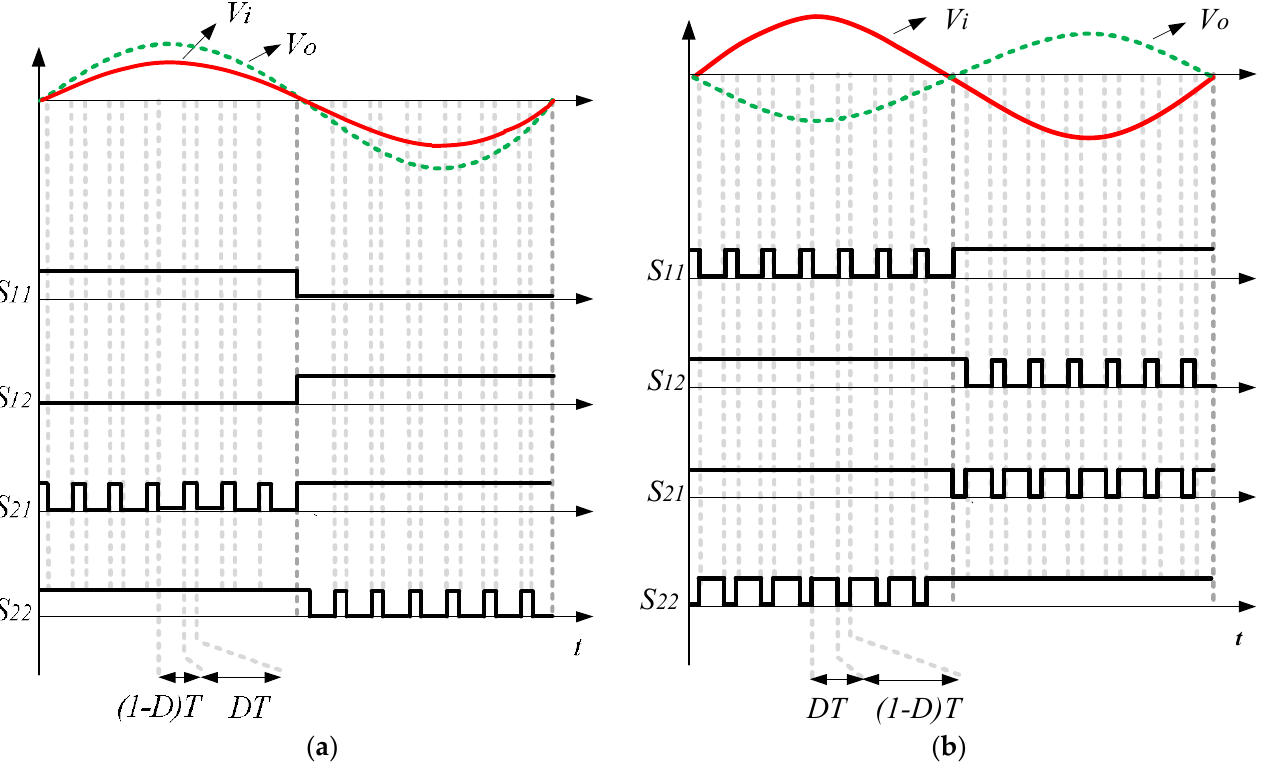
Figure 4. Switching signals of safe commutation approach in ( a ) boost in-phase mode and ( b ) buck/boost out-of-phase mode.